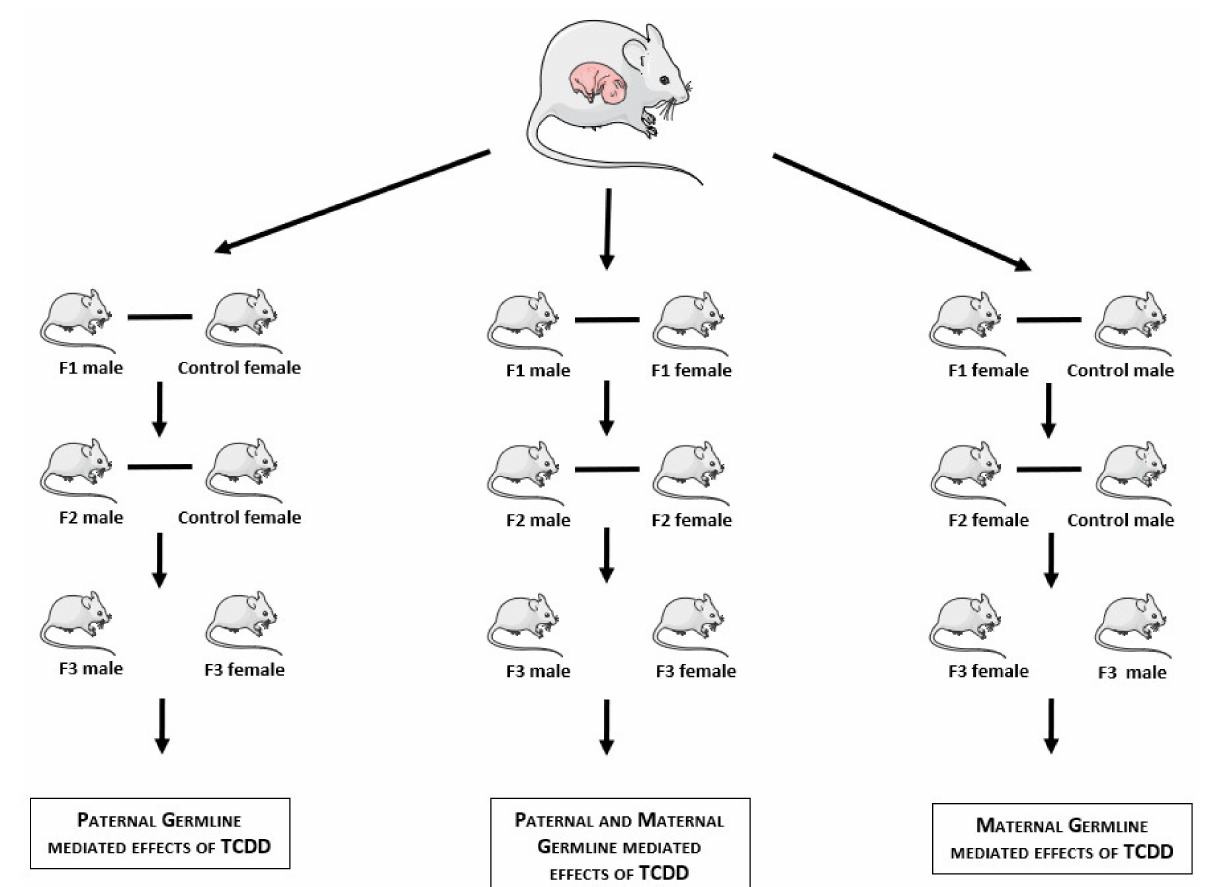
Figure 1. Summary of different experimental designs included in this systematic review